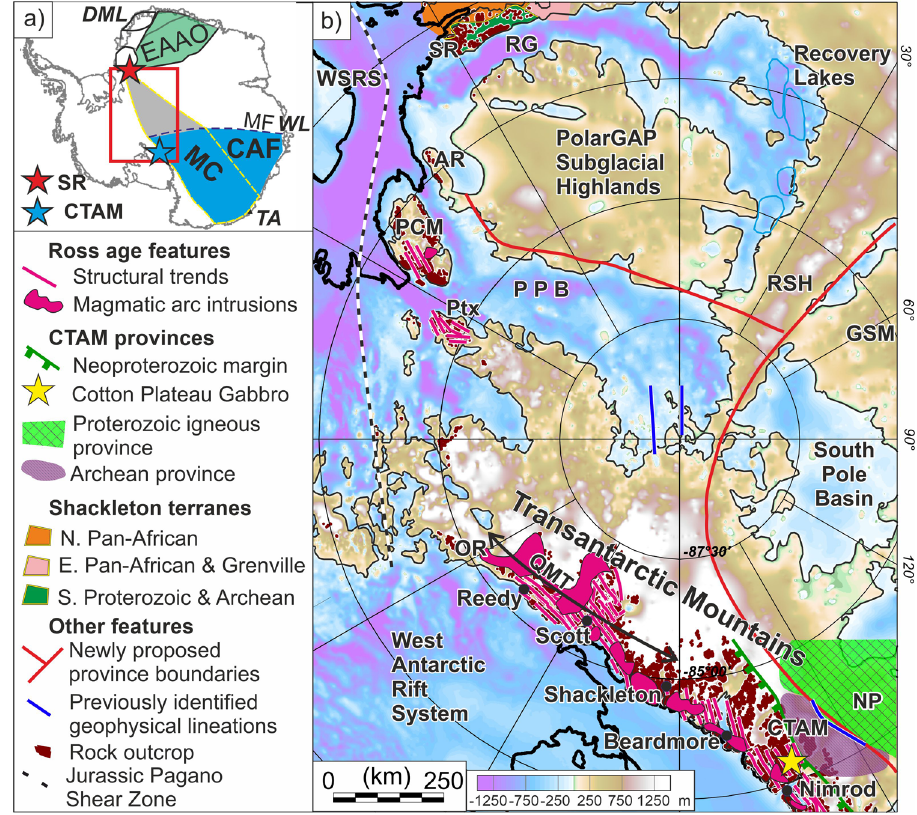
Fig. 1 Geological setting of the study area. a Study area (red box) in its Antarctic context. The Mawson Continent includes the >1700 Ma Mawson Craton (MC) and ~1500 – 1140 Ma continuations of the Australian Coompana Province and Albany-Fraser Orogen (CAF). Note alternative models for the Mawson Continent, either extending from Terre Adélie (TA) to the Shackleton Range (SR) 2 grey, or being truncated close to the Central Transantarctic Mountains (CTAM) 5,7 blue. The edge of the Mawson Continent is identi fi ed in Wilkes Land (WL) and interpreted to follow the Mirny Fault (MF) 7 . The East African Antarctic Orogeny (EAAO) shown in green in Dronning Maud Land (DML) places an additional limit on the extent of the Mawson Continent 8 . b Study area with geology and subglacial topography 48 . Note unexposed Nimrod Igneous Province (NP), and exposed but reworked Archean and Paleoproterozoic province in the CTAM 20,25 . Key glaciers dissecting the Transantarctic Mountains are named. Ross-age structural trends from mapped exposures 49 – 51 . Additional abbreviations from north to south are: Recovery Glacier (RG), Weddell Sea Rift System (WSRS), Argentina Range (AR), Pensacola Mountains (PCM), Recovery Subglacial Highlands (RSH), Pensacola-Pole Basin (PPB), Patuxtent Mountains (Ptx), Gamburtsev Subglacial Mountains (GSM), Ohio Range (OR) and Queen Maud Terrane (QMT) (black arrow) 15,16